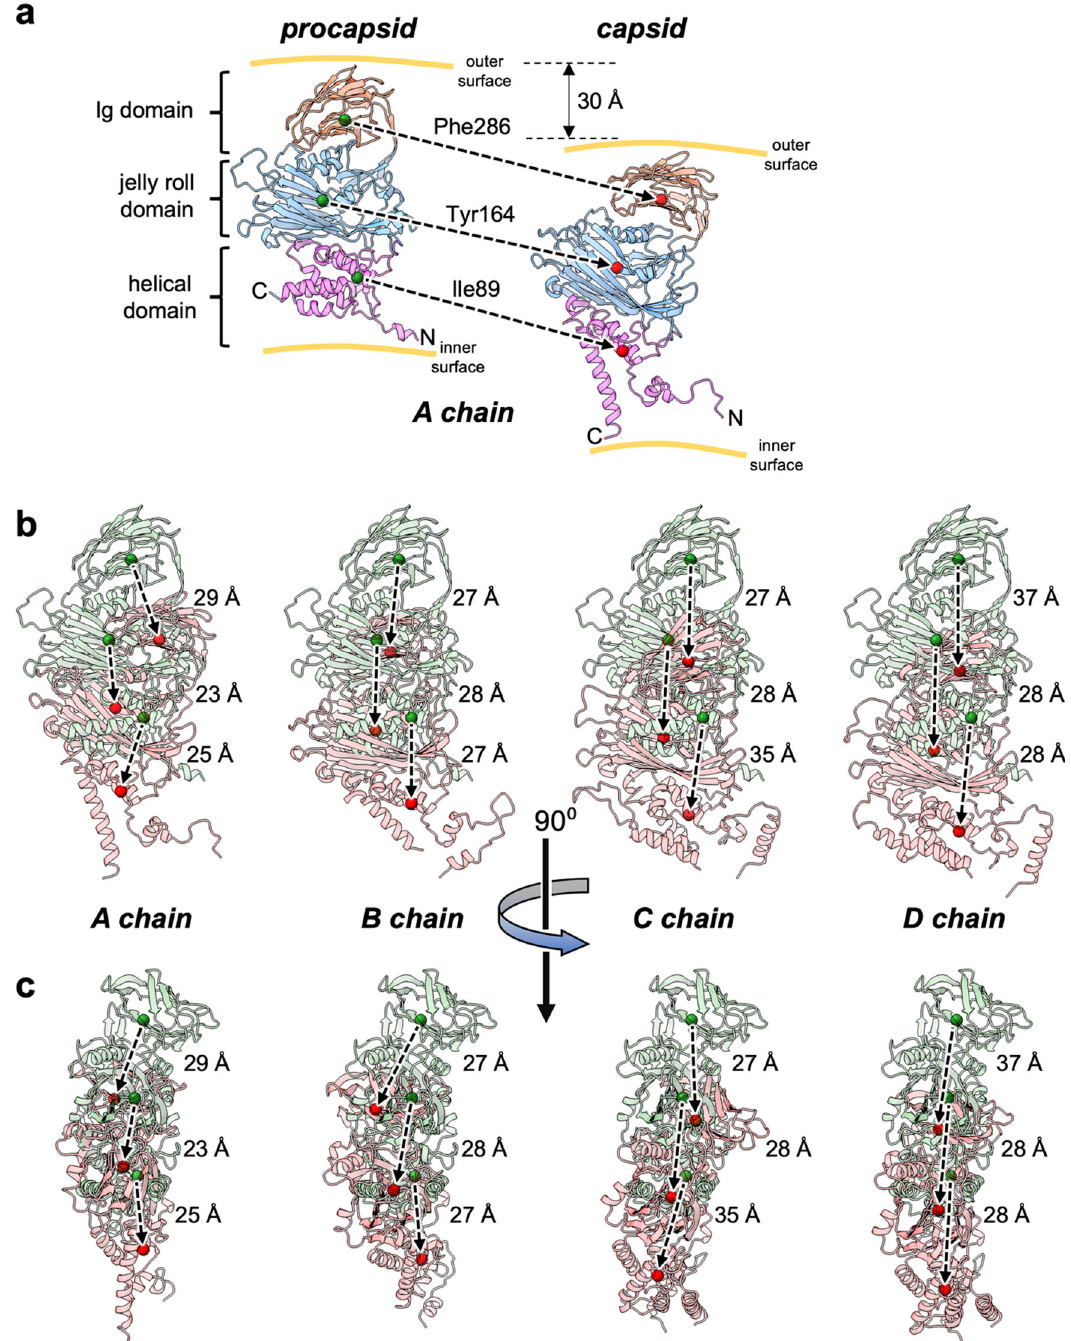
Fig. 7 Trajectories of subunit motions on maturation from procapsid to capsid. In addition to the signi fi cant refolding of the helical domain during capsid maturation, the N ω V subunits are translated through space by ~30 Å as the protein coat contracts from a diameter of roughly 480 to one of 420 Å. To track the domain movements, we have de fi ned three marker atoms that correspond to the C α atoms of equivalent residues in each subunit that lie close to the geometric centres of the three domains. a The protein backbone is shown as a semi-transparent cartoon and the marker atoms are shown as solid spheres (procapsid = green; capsid = red) with the three domains distinguished by different colours. For clarity in ( a ) only, the procapsid and capsid positions (for chain A only) have been separated horizontally, whereas in all the other panels their true relative positions are shown after superposition of the full procapsid and capsid icosahedra. For ease of comparison, in each of ( b , c ), the subunit pairs have been oriented with respect to the same procapsid subunit view, with procapsid and capsid cartoons distinguished by green and red colouration, respectively. The trajectories of the marker atoms are indicated by dashed arrows. The large structural rearrangements in the helical domains occur mostly at the periphery where they interface with neighbouring subunits or form the inner surface of the particle; the core of this domain (including the marker atom) is essentially unchanged. Furthermore, superposition of all the capsid subunits onto the procapsid subunit reveals that equivalent marker atoms overlap closely. This indicates that the relative placement of the three domains remains effectively unchanged and therefore the differences in the trajectory lengths between the subunit pairs mostly re fl ect different combinations of rigid body translations and rotations of the subunits rather than conformational